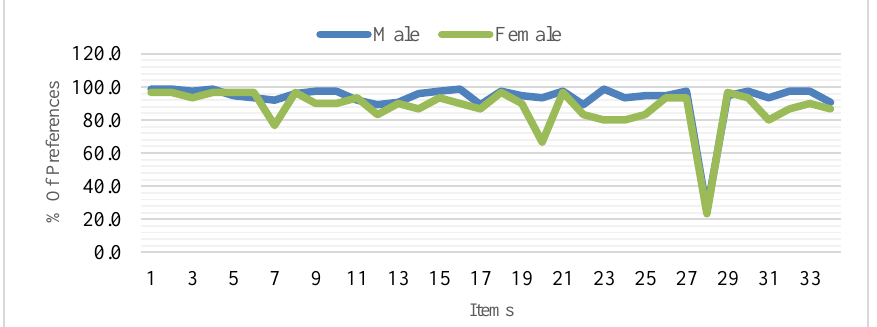
Fig. 3. Preferences of the different items related to the evaluation of the training course in EP by gender.